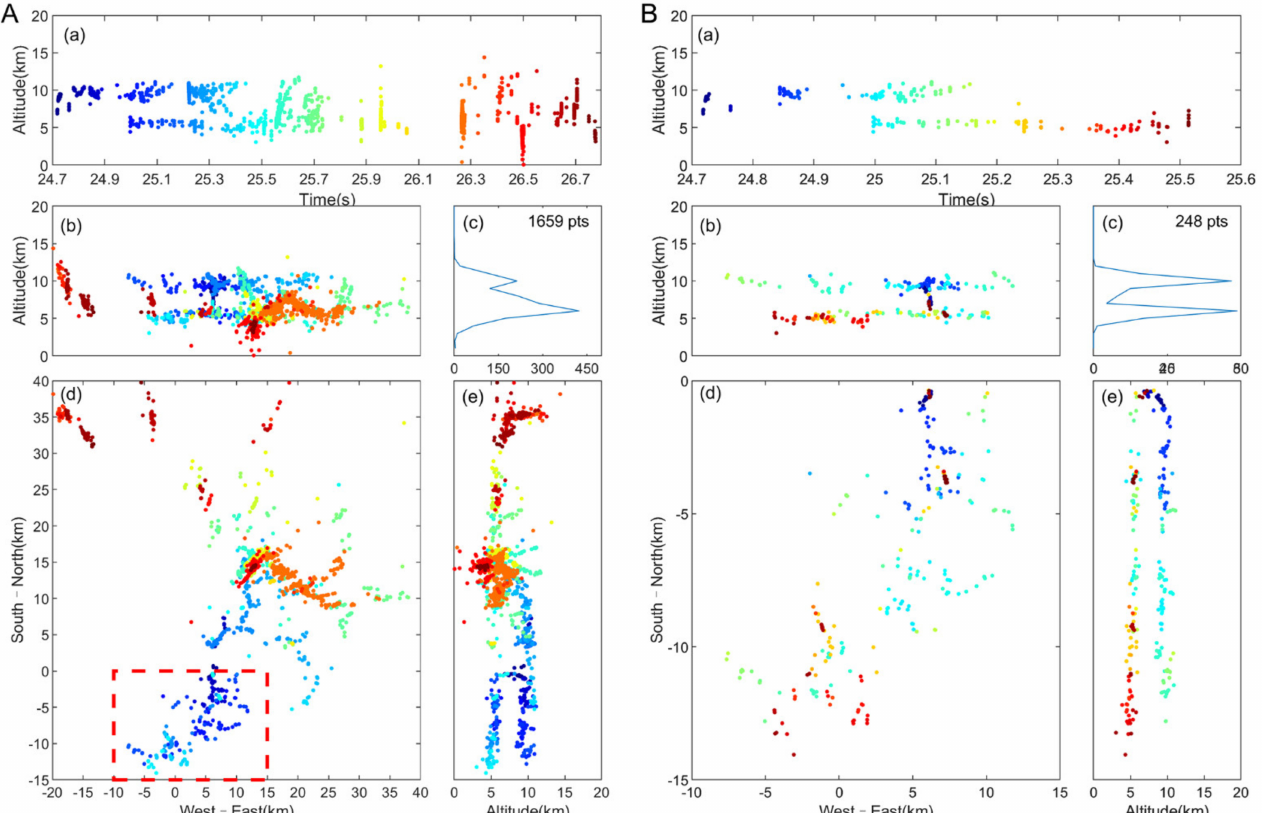
Figure 8. ( A ) Positioning results of a lightning process at 16:26 on 15 August 2015 by the TOA–TR method and ( B ) the partial development. In each subgraph, ( a ) height–time plots; ( b ) north–south vertical projection; ( c ) height distribution of radiation events; ( d ) plan view; and ( e ) east–west vertical projection of lightning radiation sources. Refer to Figure 6 of Chen et al. [46], the graph is redrawn based on the data from https://zenodo.org/record/2644811#.YEB-PU7isdV (accessed on 4 March